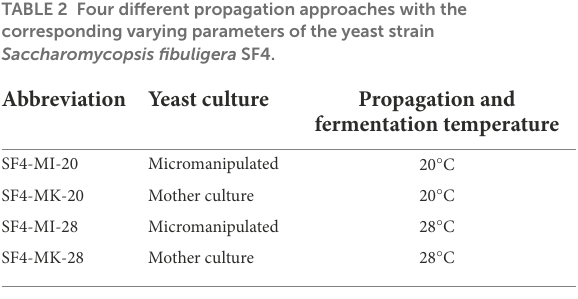
TABLE 2 Four different propagation approaches with the corresponding varying parameters of the yeast strain Saccharomycopsis fibuligera